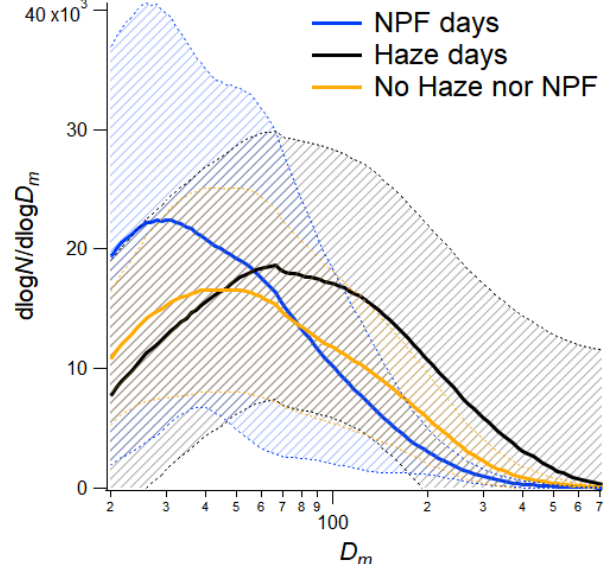
Figure 3. Average particle size distribution of NPF days, haze days and no haze nor NPF event days. The shaded areas represent 1 stan- dard deviation. The average size distribution of PMF input is dis- played in Fig. S19 in the Supplement. NPF days were excluded from the PMF